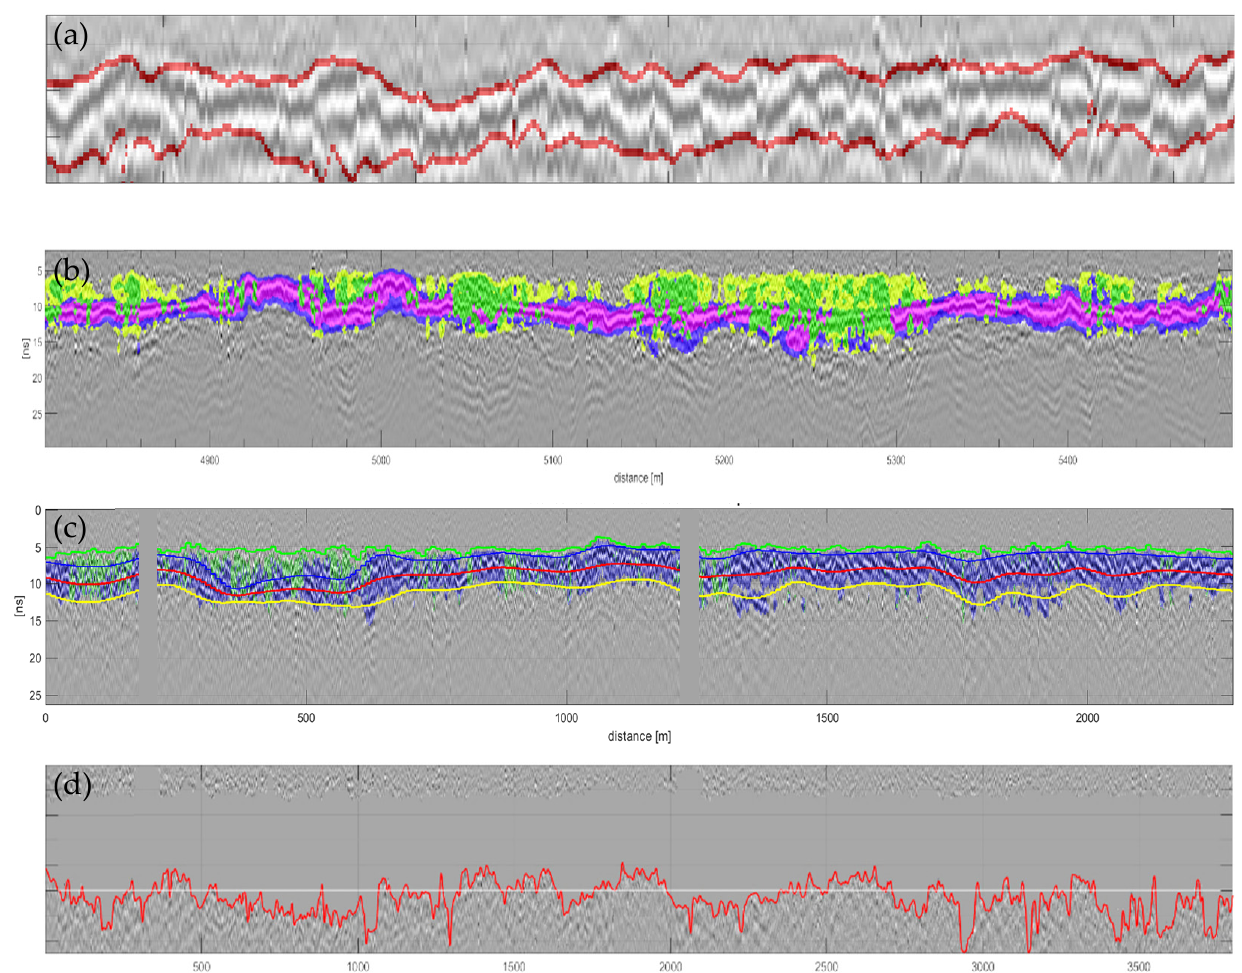
Figure 11. ( a ) Automatically extracted upper and lower limits of a railway planum (indicated in red), ( b ) a segmentation example where different colors indicate high– and low-frequency segments having high amplitudes exceeding a certain threshold; ( c ) automatic layer boundary extraction (green, red, yellow) relevant for water content estimation; ( d ) automated line extraction (red) for subgrade analysis.